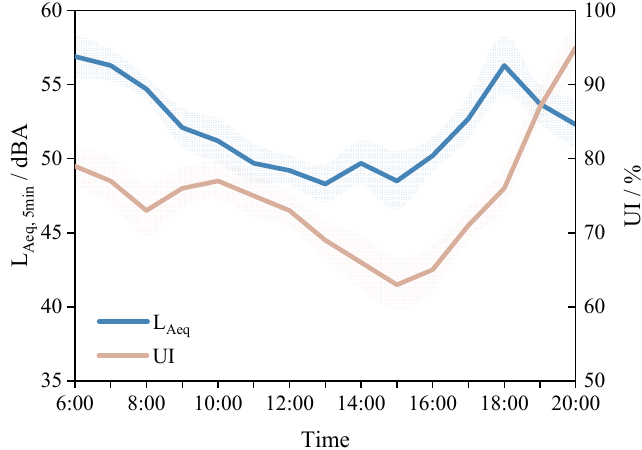
Figure 3. Diurnal variation of 5-min, A-weighted, equivalent sound pressure level ( L Aeq,5min ) and uniformity of illuminance (UI) in urban forests.